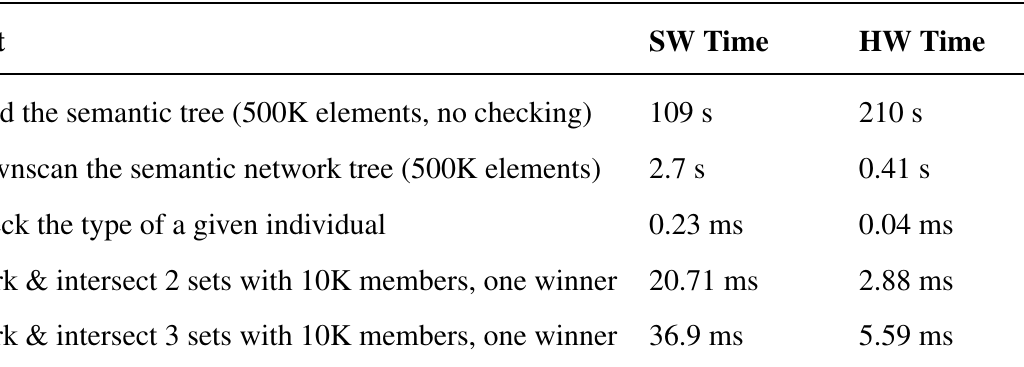
Table 3. Mean execution time of relevant Scone reasoning operations in the HRP and Dell workstation. 500 executions of each test were carried